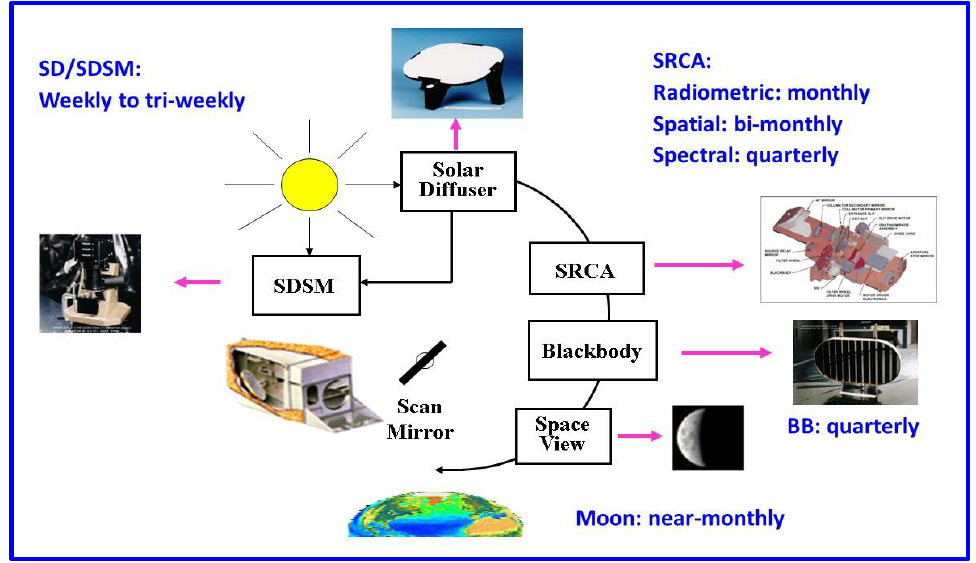
Figure 9. Schematic of MODIS on-orbit calibration and characterization approaches and nominal scheduling frequencies.